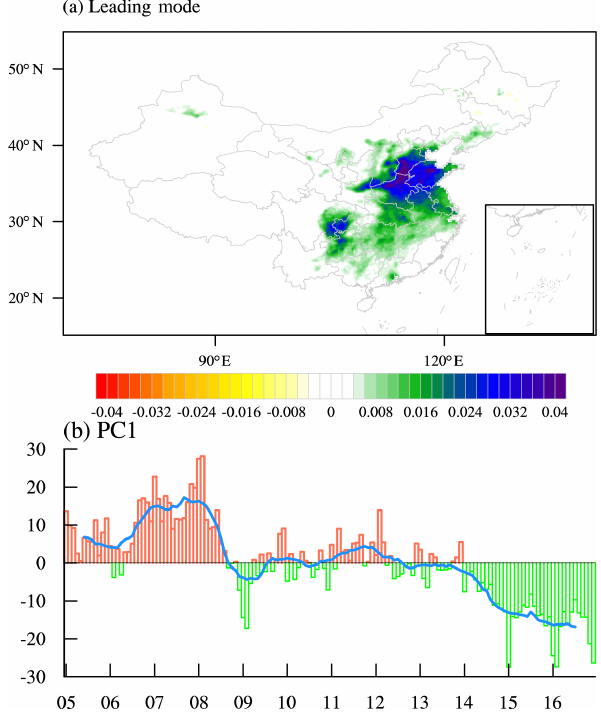
Figure 7. The first leading EOF mode (a) and the corresponding principal component (b)